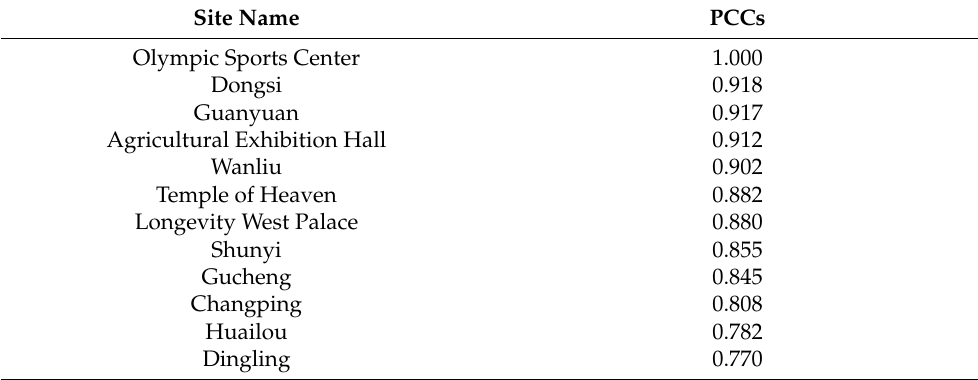
Table 7. PM 10 correlation of each station.